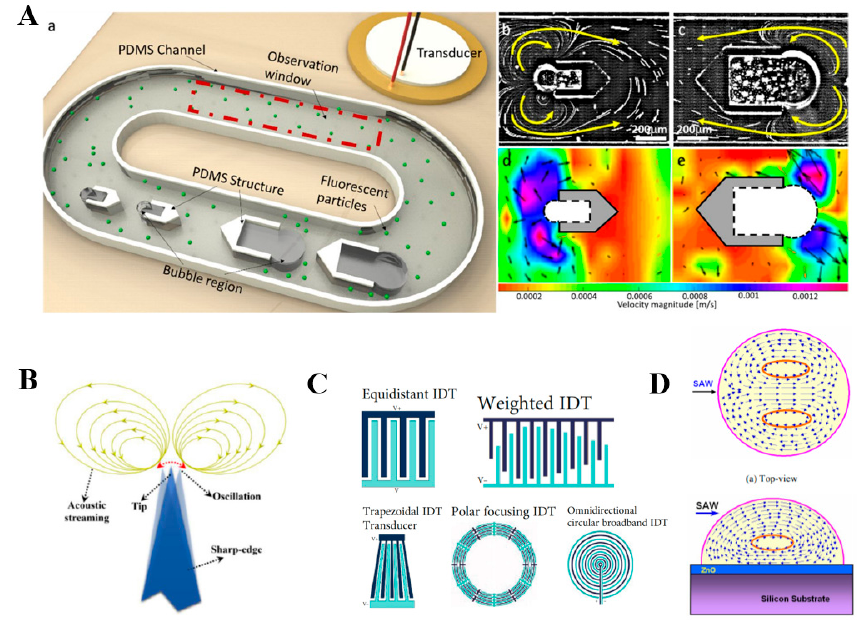
Figure 9. Acoustic-actuated microrobots for microfluidic operation. ( A ) Configuration of the acoustics-based bi-directional micropump device. (A-a) Experimental device structure; (A-b, A-c) acoustic microstreaming flow induced by different sized bubbles; (A-d, A-e) The velocity of particle movement in the microchannel. The actuation voltage is 5 Vpp and the frequencies are 24 kHz and 19 kHz, respectively. ( B ) A typical phenomenon of acoustic streaming produced by a sharp-edge structure in the microfluidic device. ( C ) Different structures of IDT. ( D ) Working schematic diagram of microstirrer. Reproduced with permission from Refs. [81–83,87], respectively.